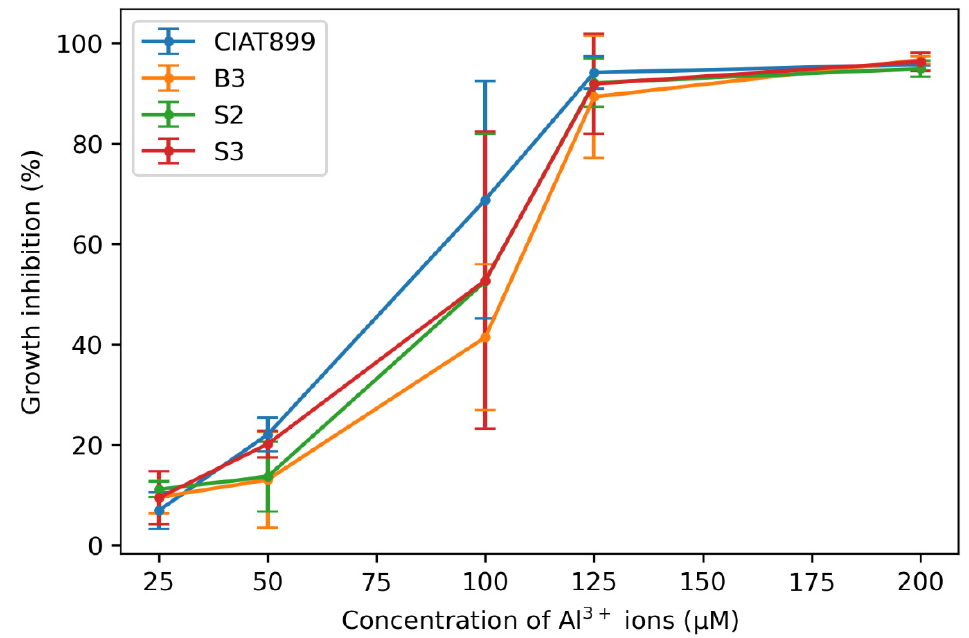
Figure 1. Percent growth inhibition of isolates B3, S2, S3, and standard R. tropici CIAT899 in media with Al at pH 5.5.